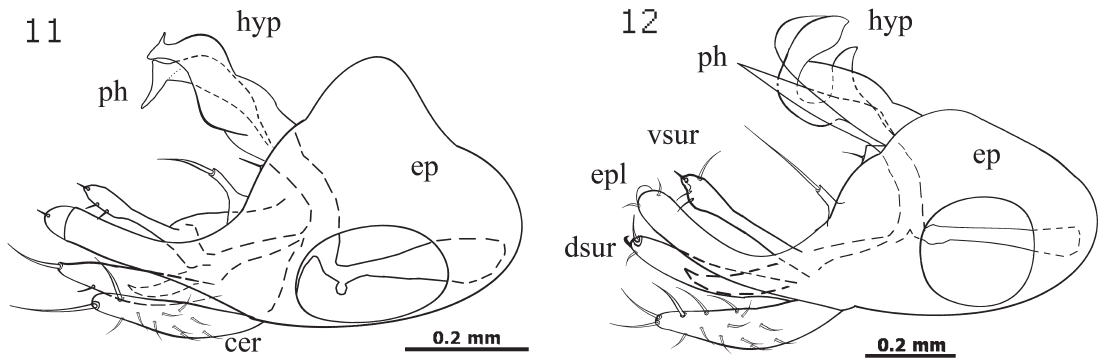
tsitsikamma sp. nov. Abbreviations: cer = cercus; ep = epandrium; epl = epandrial lobe; hyp = hypandrium; ph = phallus; dsur, vsur = dorsal and ventral lobes of